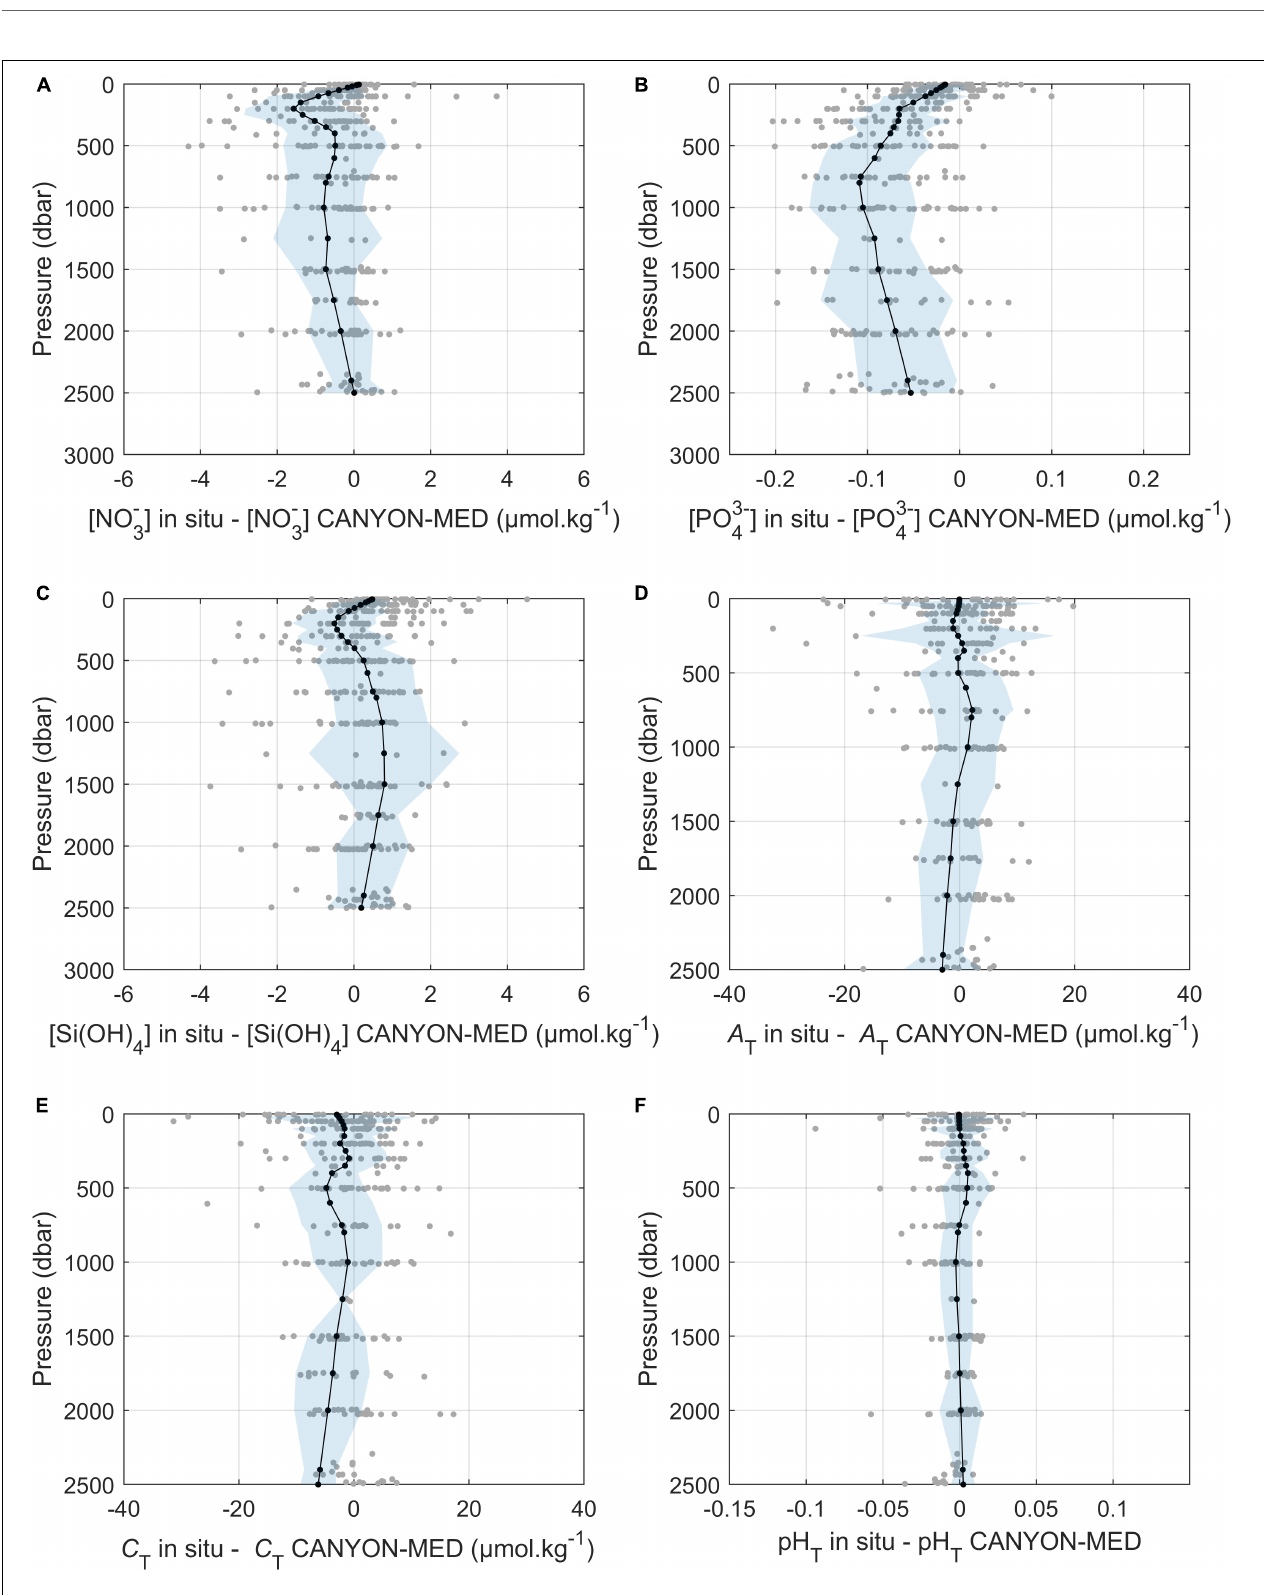
FIGURE 5 | Vertical profiles of the differences between in situ measurements from the ANTARES time series and the values predicted by CANYON-MED for (A) NO − 3 , (B) PO 3 − 4 , (C) Si(OH) 4 , (D) A T , (E) C T , and (F) pH T . The black line represents the mean value and the shaded area represents the standard deviation around this mean value. The statistics of the corresponding regression are presented in Table 3